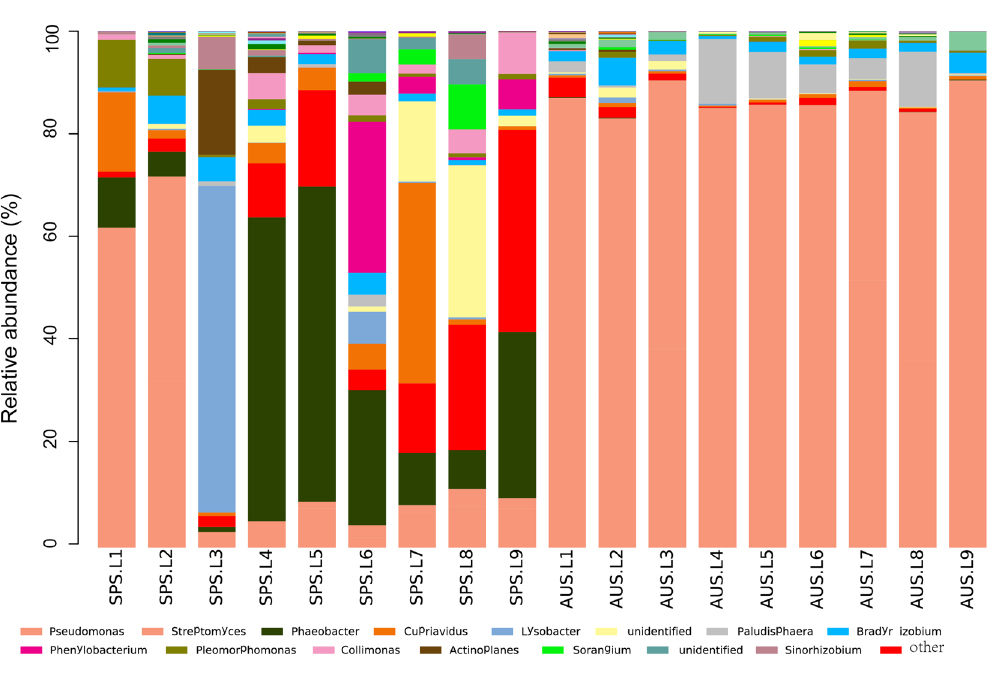
Figure 4. Relative abundance and composition of phoD -harboring bacterial genera detected in the sediments of Sancha Lake in the spring and autumn. SPS Spring Location, AUS Autumn